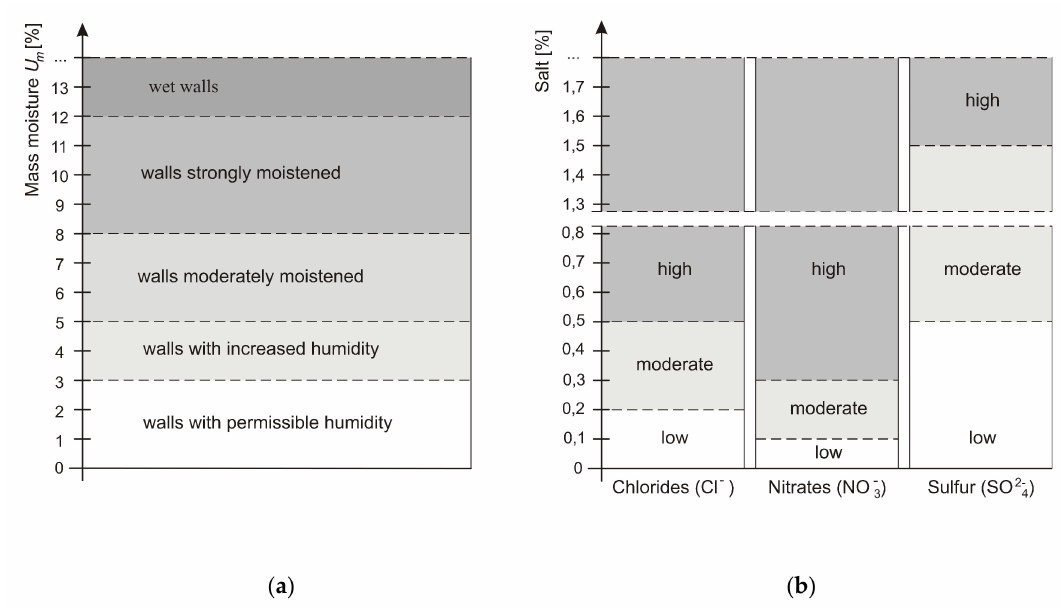
Figure 1. Classification of the moisture ( a ) and salinity ( b ) of brick walls (based on